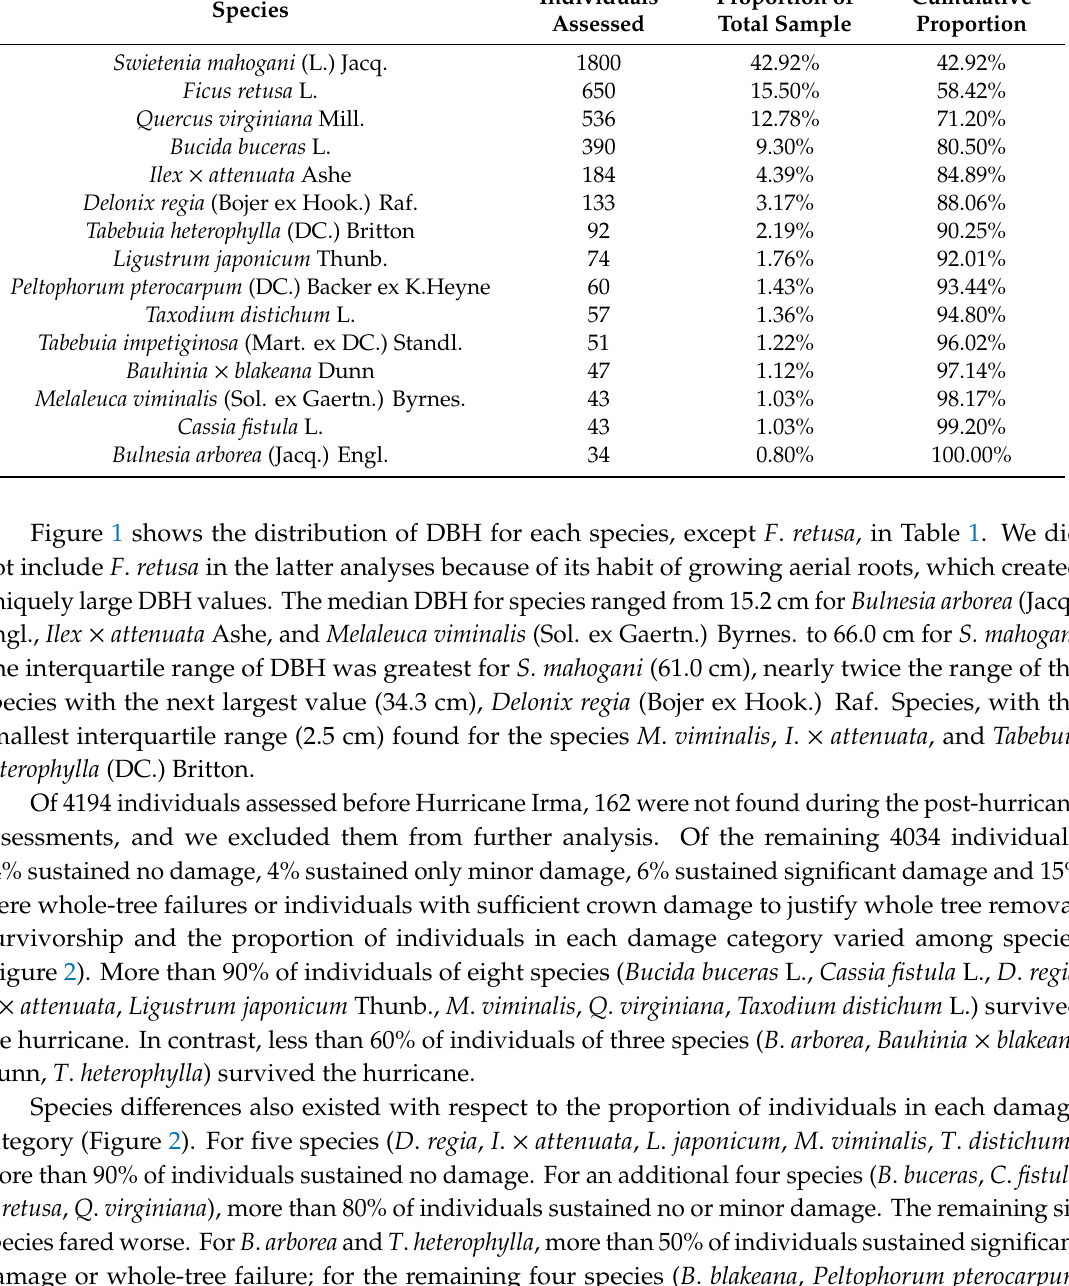
Individuals Proportion of Cumulative Assessed Total Sample